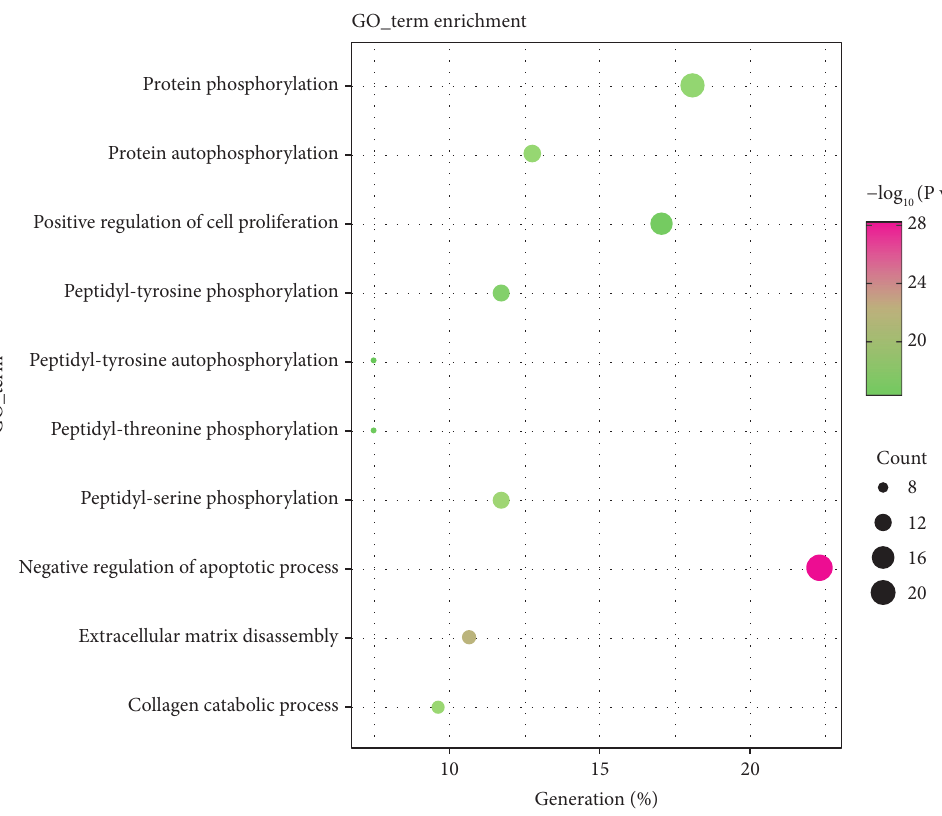
Figure 5: BP in GO enrichment